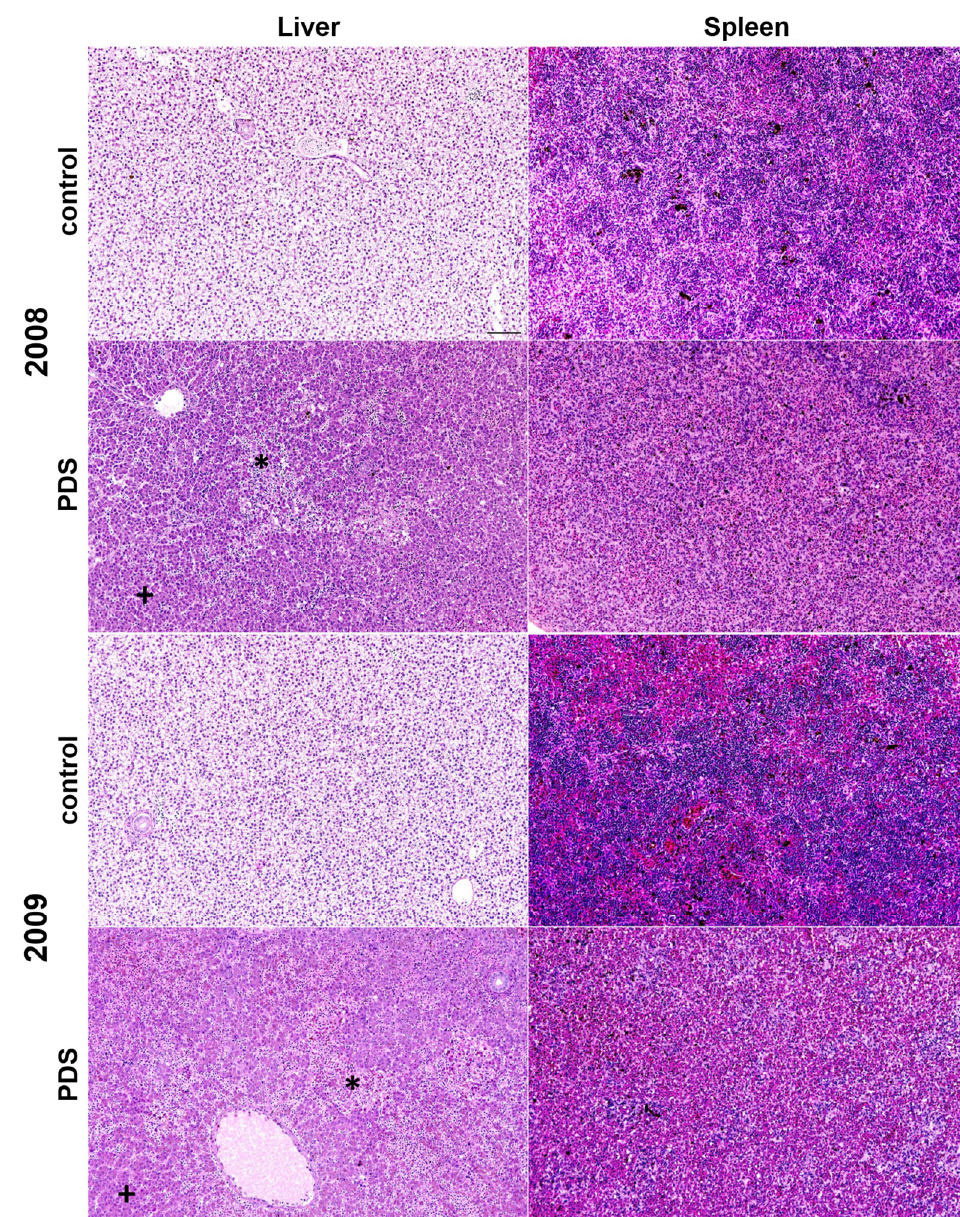
Figure 3. Organ lesions of brown trout of the exposure experiments in 2008 and 2009 with proliferative darkening syndrome (PDS) compared to the control animals. The livers of PDS-affected brown trout displayed multifocal random bridging liquefactive necrosis (*) and viable hepatocytes with eosinophilic cytoplasm (diminished glycogen storage, +). The livers of the control animals displayed physiologic diffuse clear cytoplasmic vacuolation of hepatocytes (glycogen storage) without necrotic foci; the bar = 100 µ m (same magnification in all pictures). The spleens of PDS-affected brown trout displayed a pronounced depletion of lymphocytes when compared to the spleens of the control